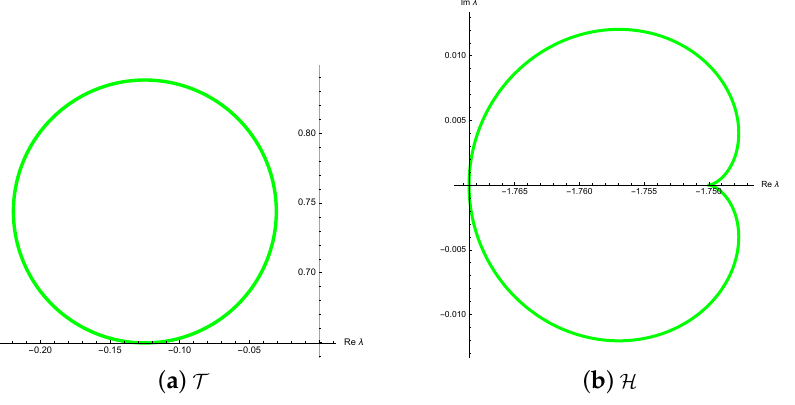
Figure 7. Curves T and H respectively resembling B 1 and B 3